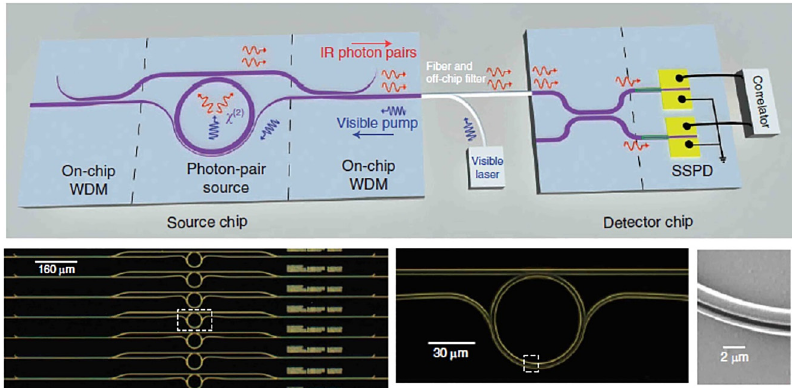
Figure 11: Aluminium nitride micro-ring parametric-down conversion source